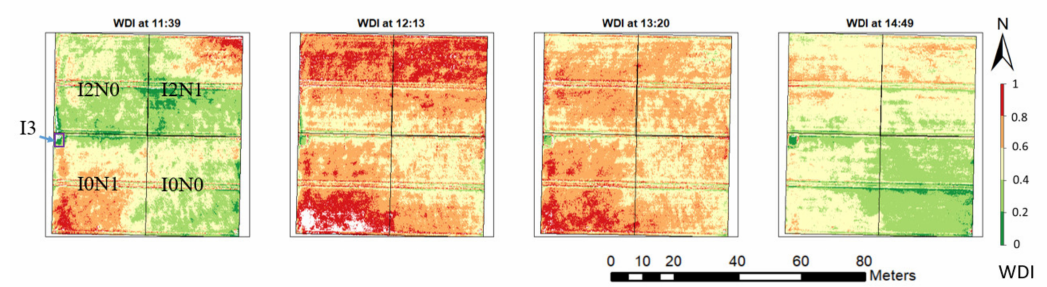
Figure A6. Spatiotemporal distribution of the WDI of winter wheat on the diurnal scale on 28 June 2019 in Denmark. I0 and I1 are minimum and full irrigation, respectively, and I3 is a small (3 × 2 m) plot that was separately irrigated before the day of the flight on 28 June